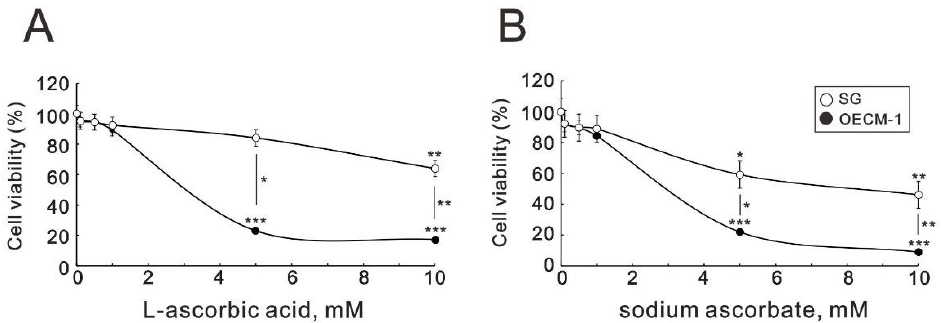
Figure 1. Effects of L-ascorbic acid and sodium ascorbate on cell viability in OECM-1 and SG cells. ( A ) and ( B ) OECM-1 (6 × 10 4 ) and SG (6 × 10 4 ) cells were cultured in 24-well plates and treated with the indicated concentrations of L-ascorbic acid ( A ) for 5 h and sodium ascorbate ( B ) for 3 h. Cell viability was measured using the MTT method. Bars depict the mean ± SD of three independent experiments. Student’s t -tests were analyzed and compared with vehicle. * p < 0.05, ** p < 0.01, and *** p < 0.001.